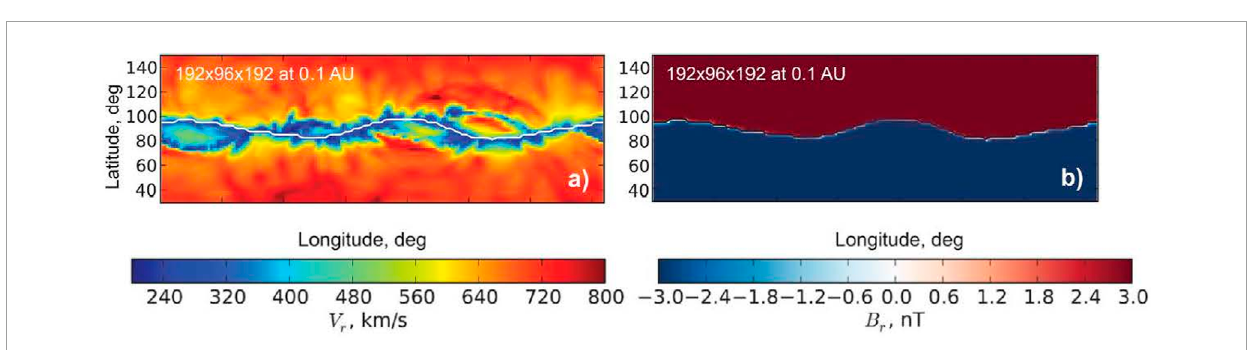
Frontiers in Astronomy and Space